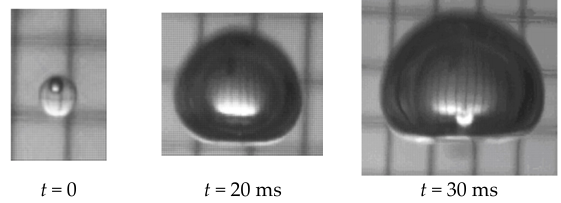
Figure 4. Phase change (boiling) of a 2 mm propane droplet while moving due to buoyancy within a column of water at ambient temperature and pressure (data adapted from Haustein et al. [31]).